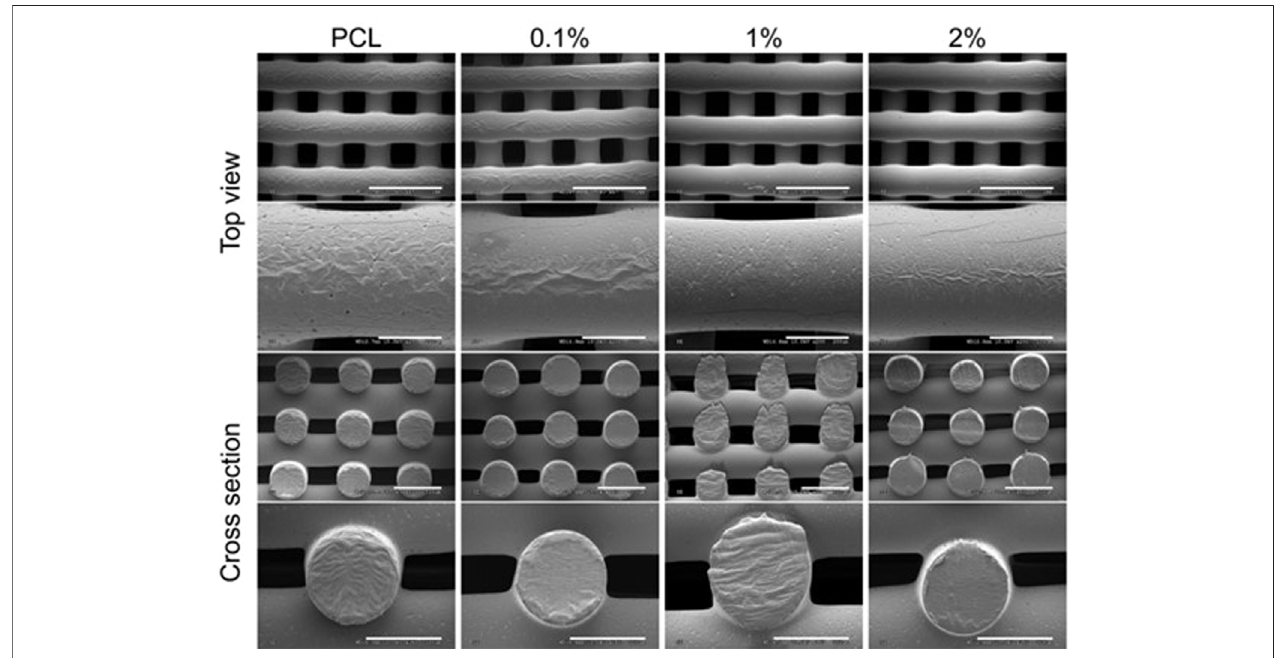
FIGURE 7 | SEM images ofPCL/ PANI scaffolds with varying PANI fi ller loading (0.1, 1, and 2% wt.). From top tobottom, the scale bars are 1 mm, 200 m, 500 m, and 300 m. Image was adapted from Wibowo et al. (2020) under the Creative Commons Attribution License.